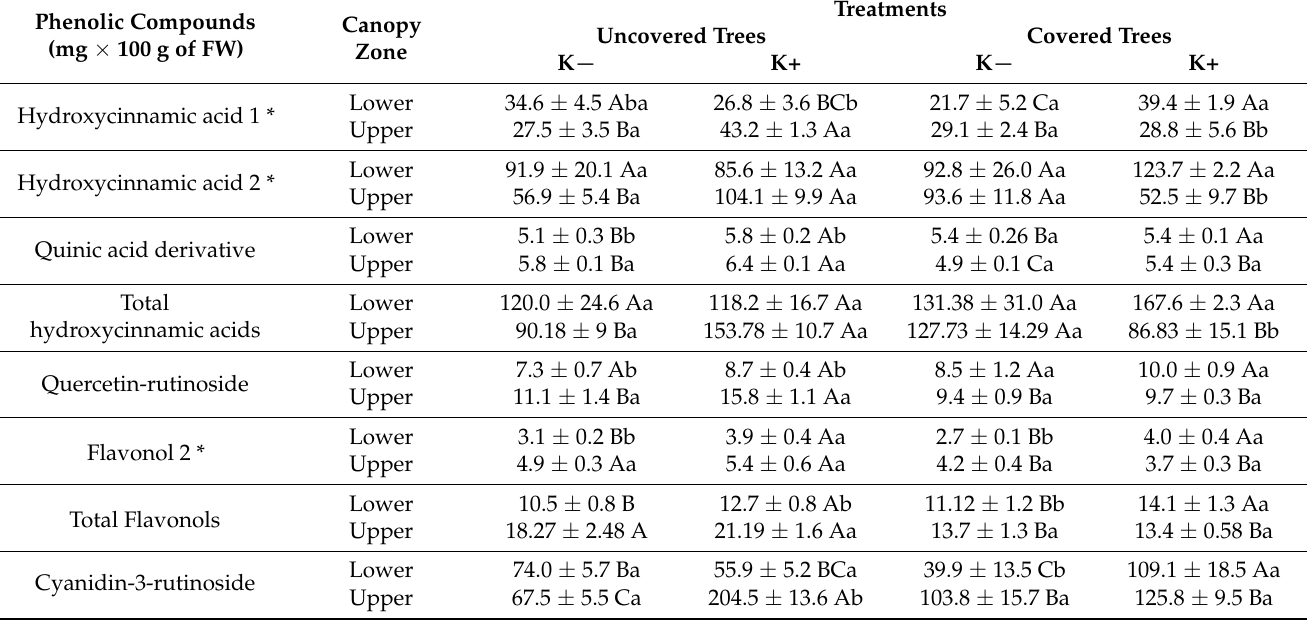
Table 5. Effect of two potassium spray treatments on phenolic compound produced in covered and uncovered trees: conventional K regime (4 sprays during the season: K − treatment) or intensive K regime (7 sprays during the season: K+ treatment). Fruits from the upper and lower zone of the canopy were separately